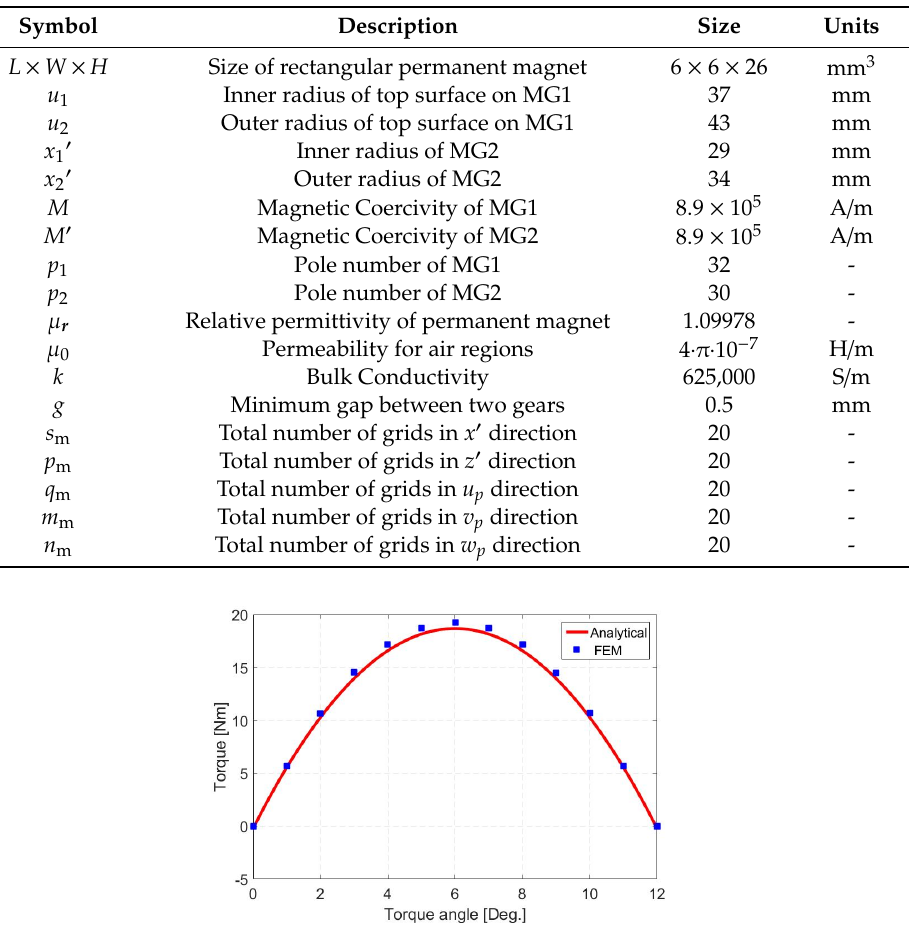
Table 3. Parameter values.